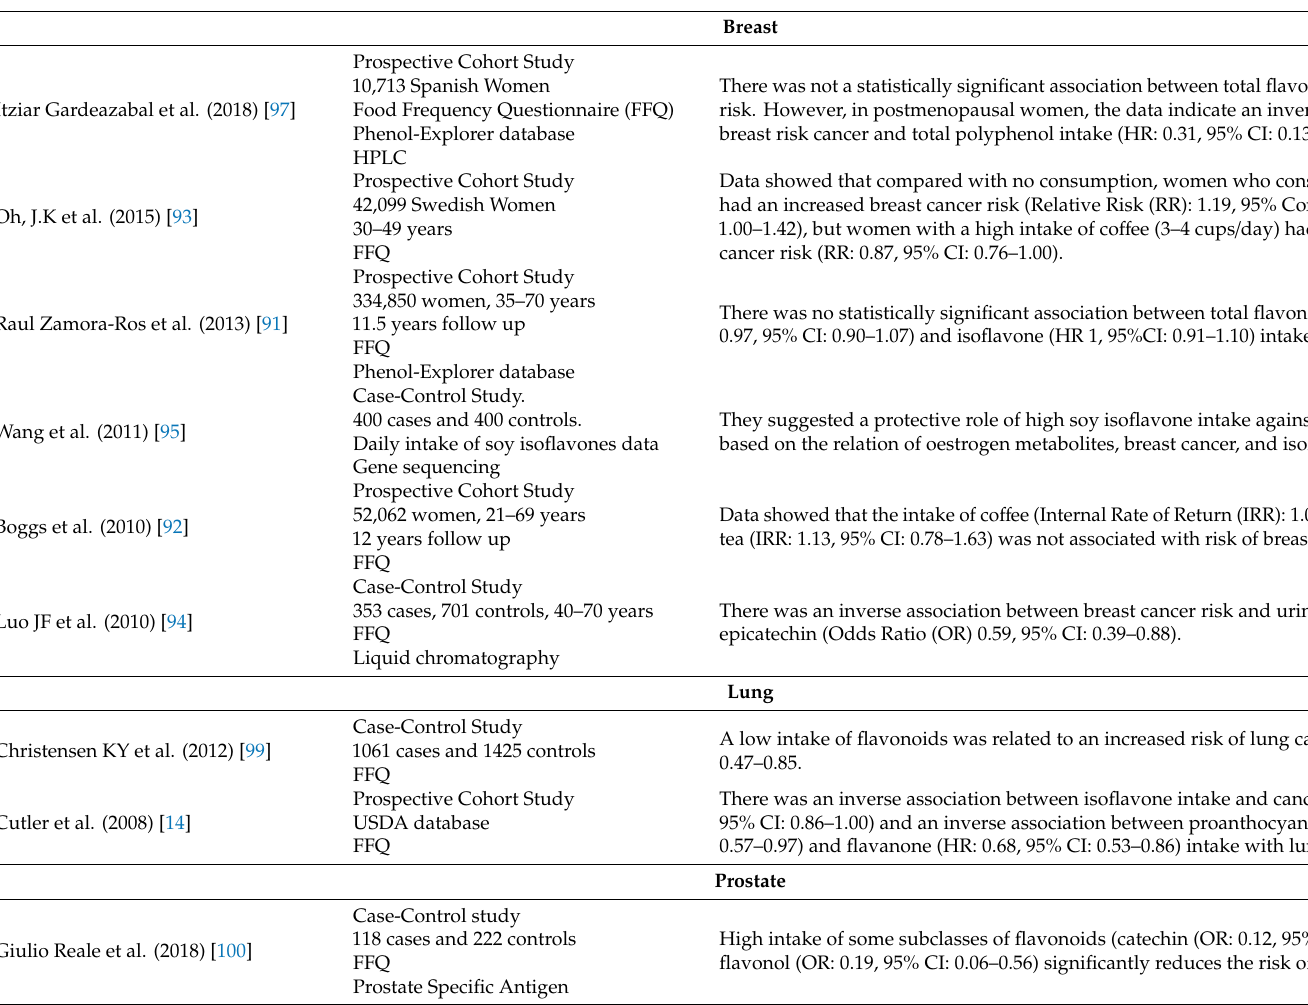
Table 10. Association between flavonoid intake and risk of breast, lung, and prostate